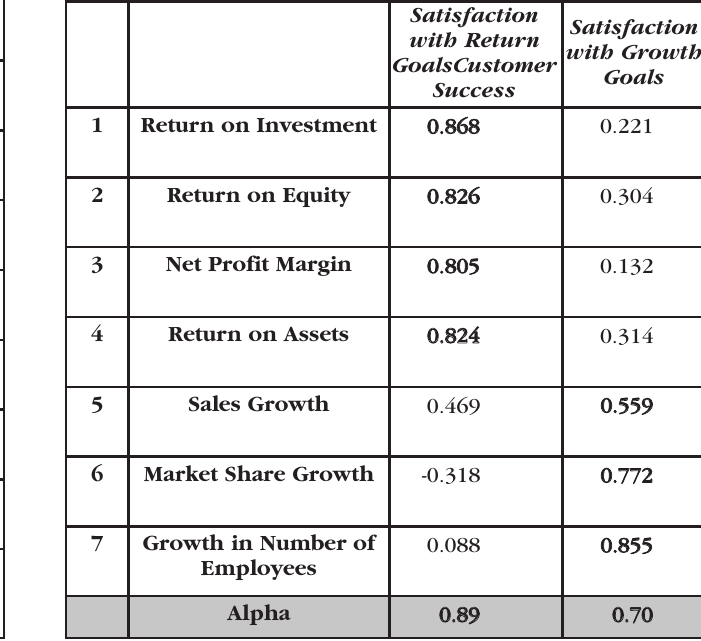
Satisfaction with